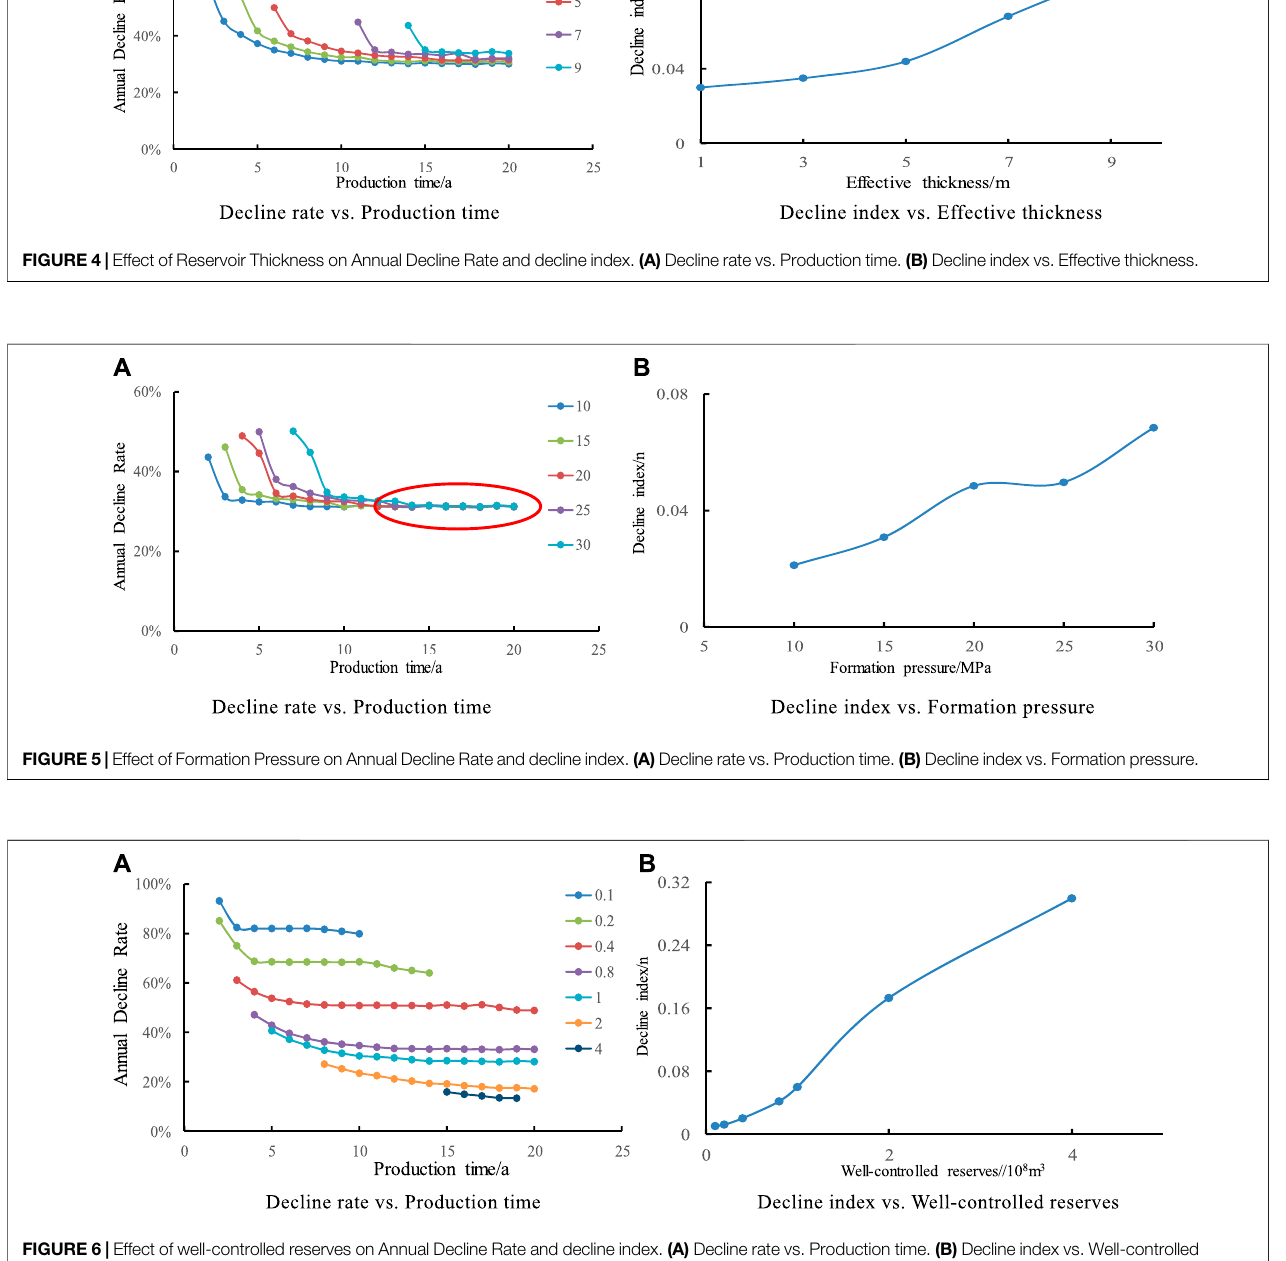
Frontiers in Physics |